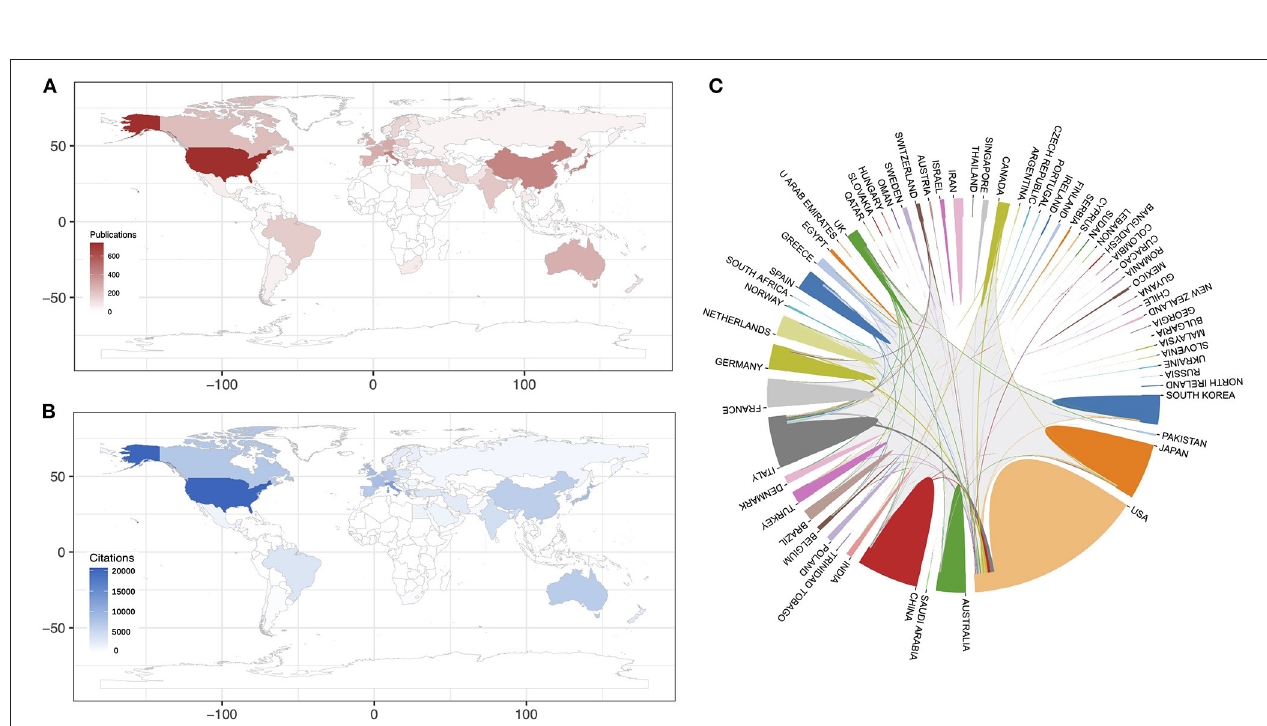
FIGURE 3 | Countries associated with the CIPN field between 2001 and 2021: (A) the number of publications arising from various countries; (B) the total number of citations from various countries, and (C) international collaboration between countries.